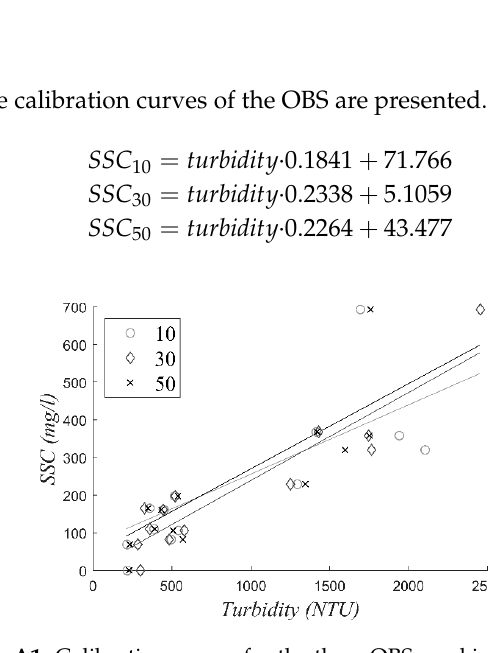
Figure A1. Calibration curves for the three OBS used in this study.